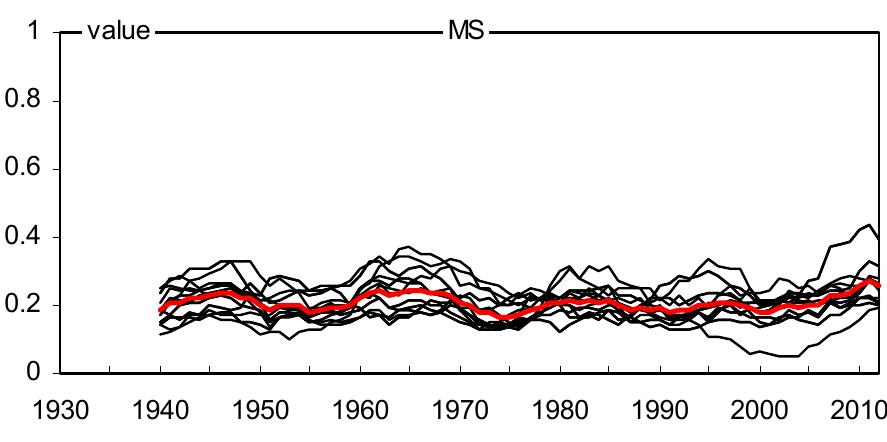
Figure 7. Eighteen site indexed chronologies.